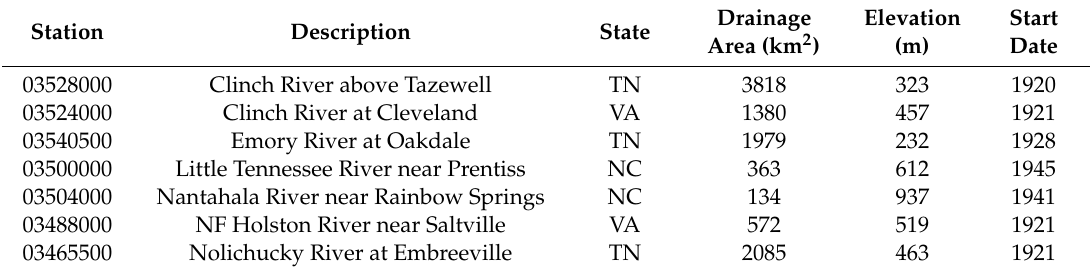
Figure 1. Location map showing the 11 United States Geological Survey (USGS) streamflow stations analyzed and all the International Tree-Ring Data Bank (ITRDB) tree-ring chronologies (TRCs) in the Southeastern U.S. Reconstruction TRCs indicate tree-ring chronologies that were found to be statistically correlated with streamflow and were used in the developed reconstructions. Non-Reconstruction TRCs indicate tree-ring chronologies that were not found to be statistically correlated with streamflow and were not used in the developed reconstructions. Table 1. Descriptions of the 11 USGS streamflow stations used for analysis.